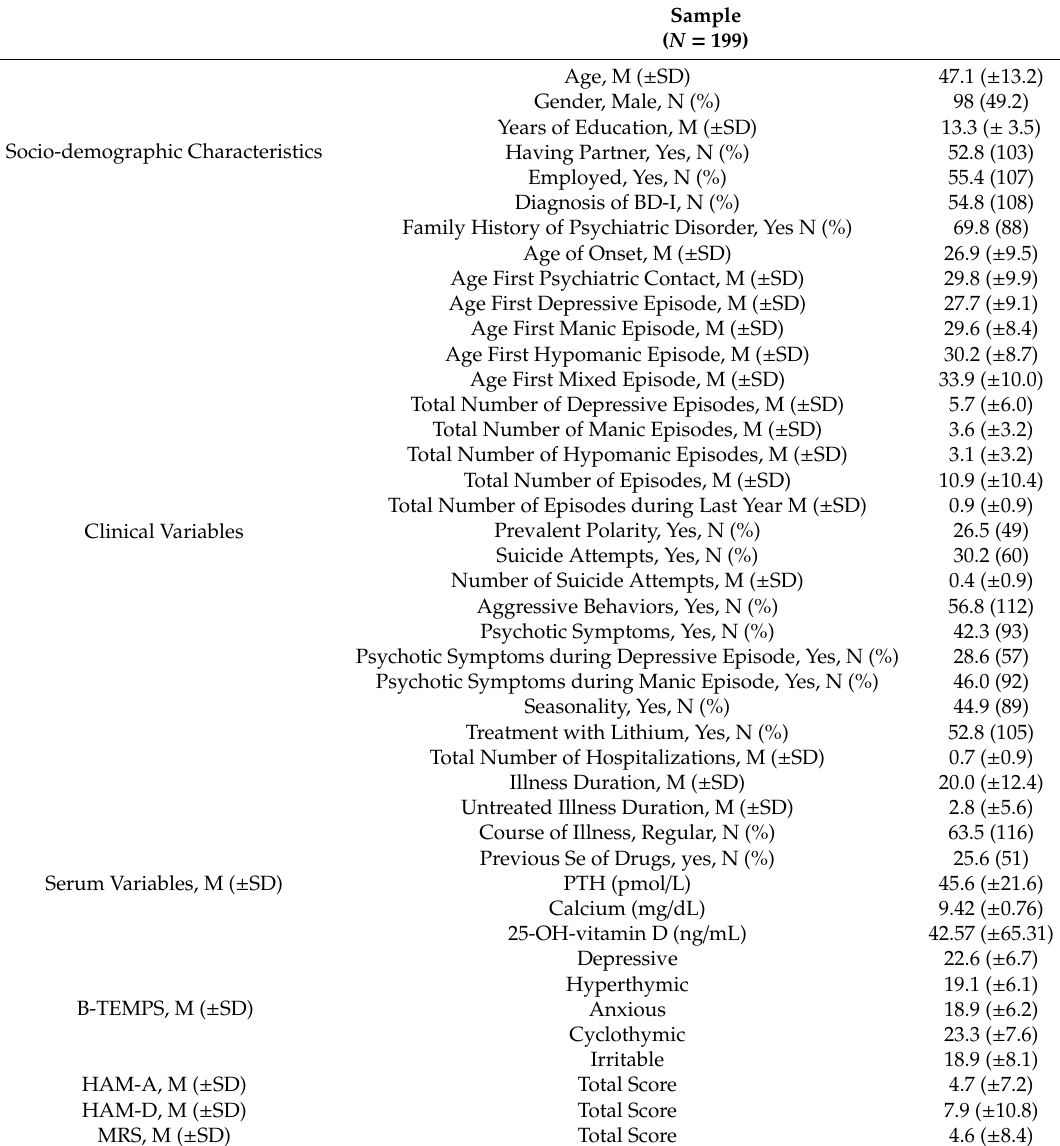
Table 1. Socio-demographic and clinical characteristic of total